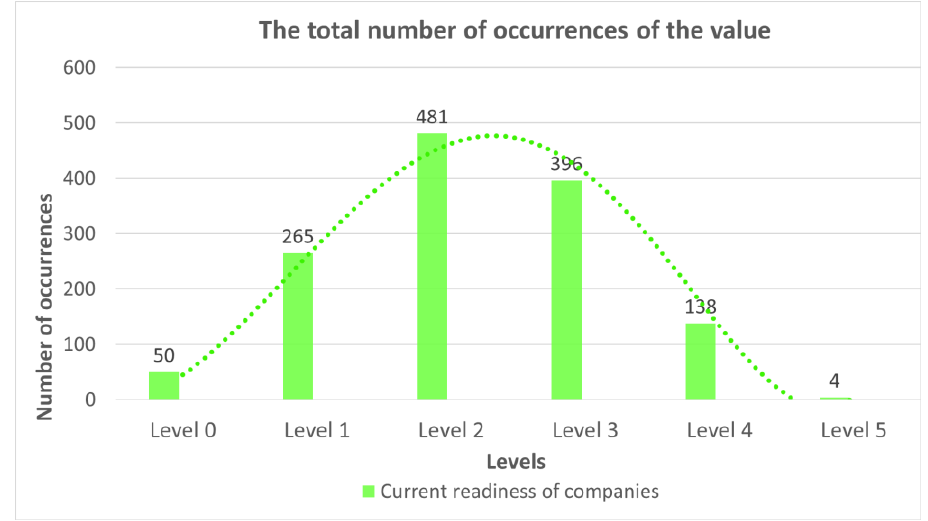
Figure 4. The number of occurrences of the current readiness level.